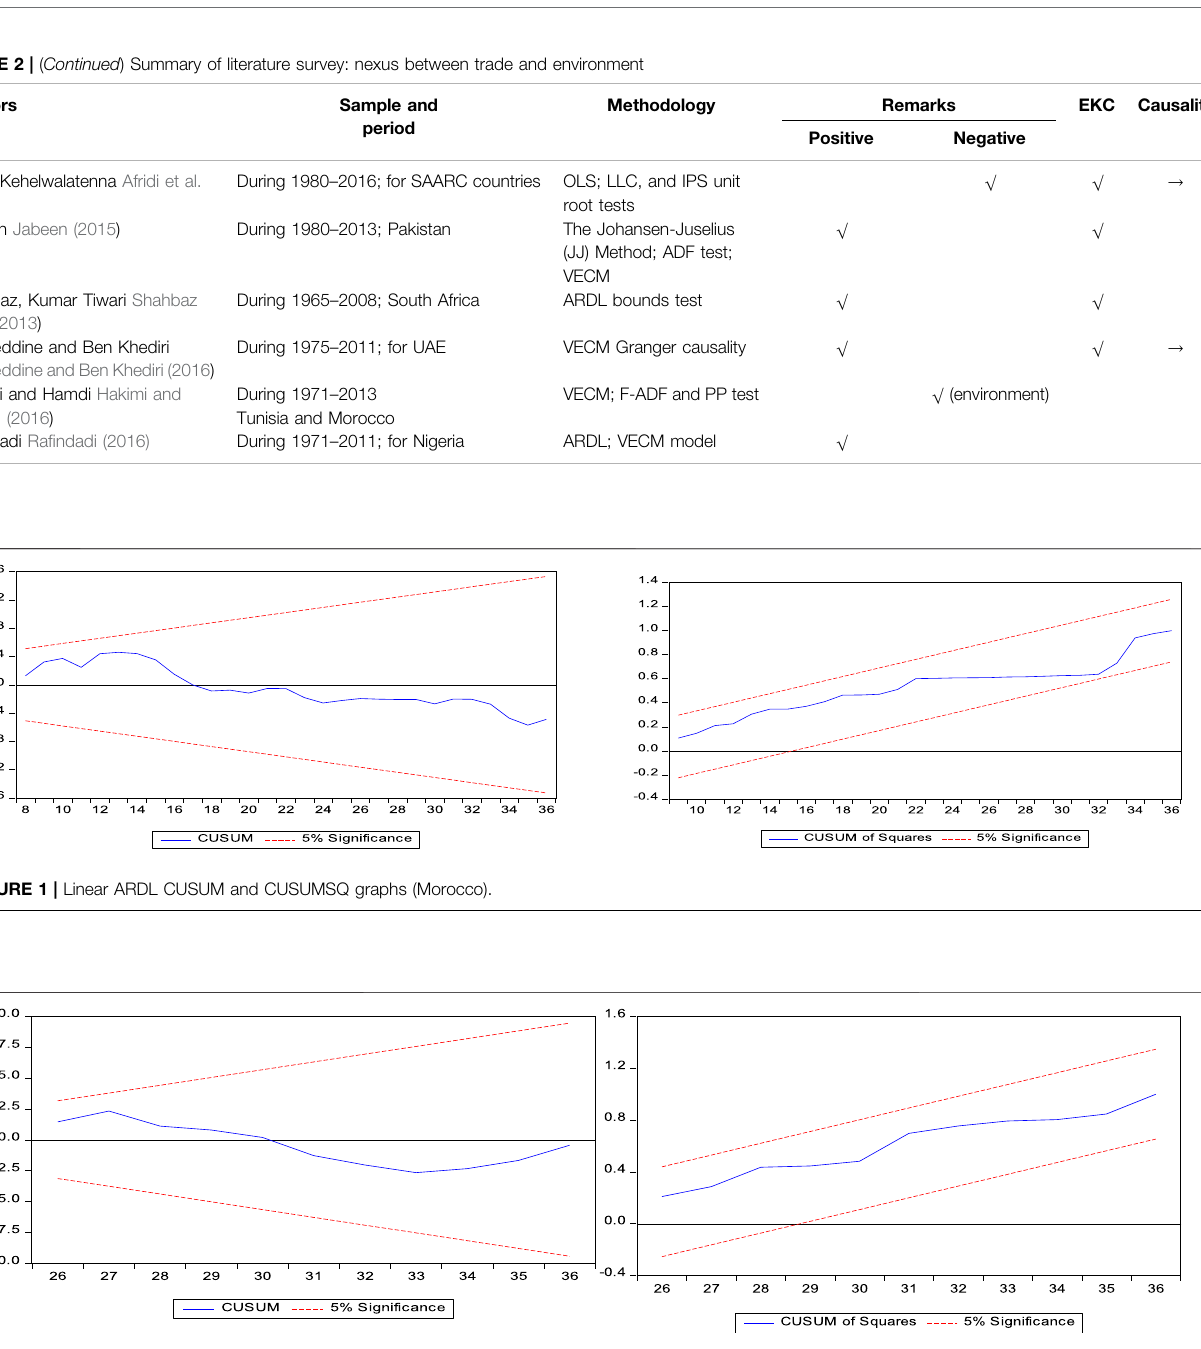
FIGURE 2 | Linear ARDL CUSUM and CUSUMSQ graphs (Tunisia). Asymmetric long- and short-run coef fi cients.